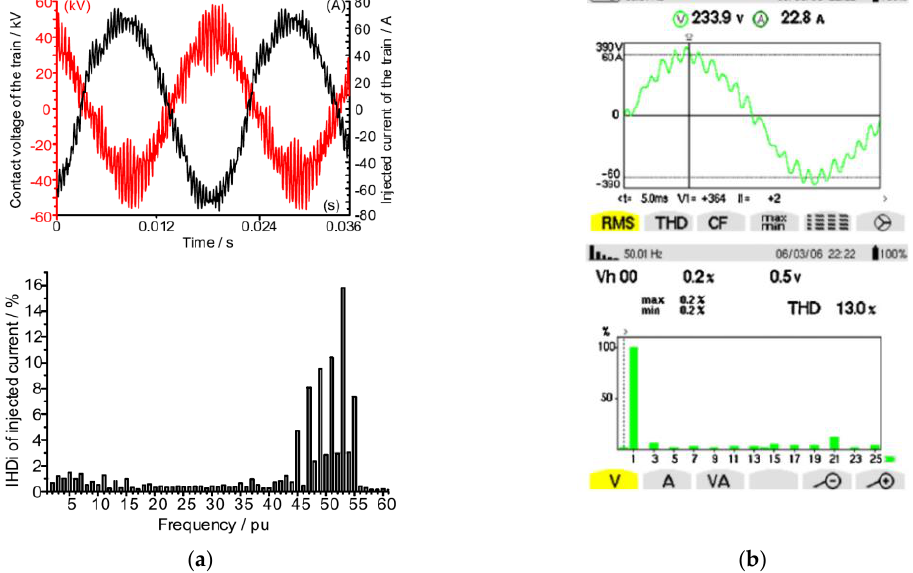
Figure 6. Distorted pantograph voltage / current under the high-frequency resonance with FFT analysis in China and Italy. ( a ) JingHu high-speed railways (HSR) [64] ( b ) Italy HSR [79]. Parallel HR